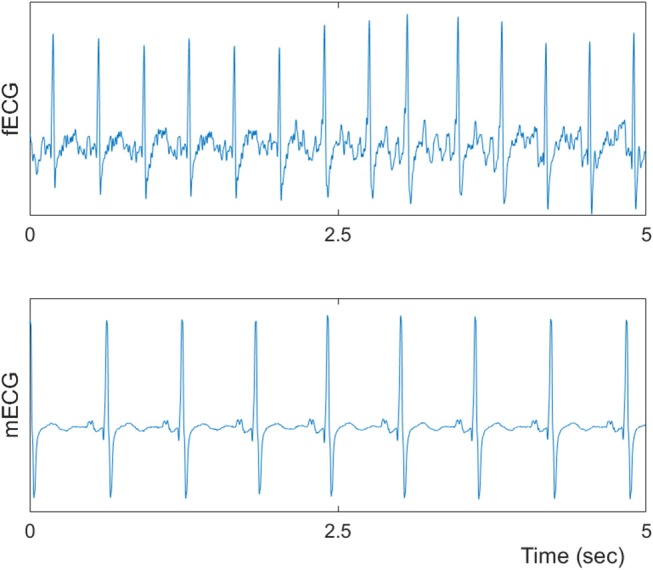
A Sample of fetal and maternal ECGs.